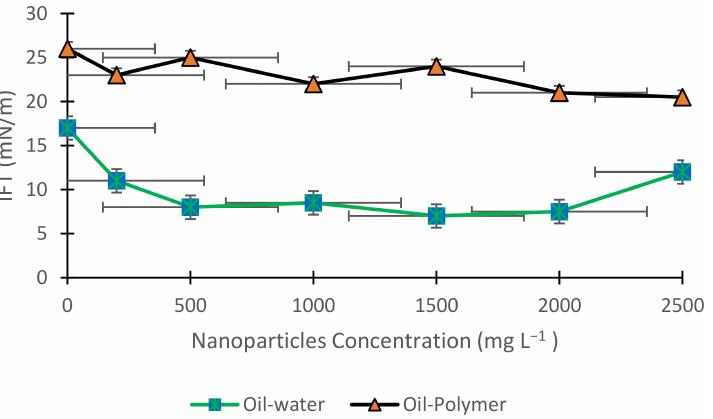
Figure 2. Interfacial tension measurement in the presence of different nanoparticle concentrations.